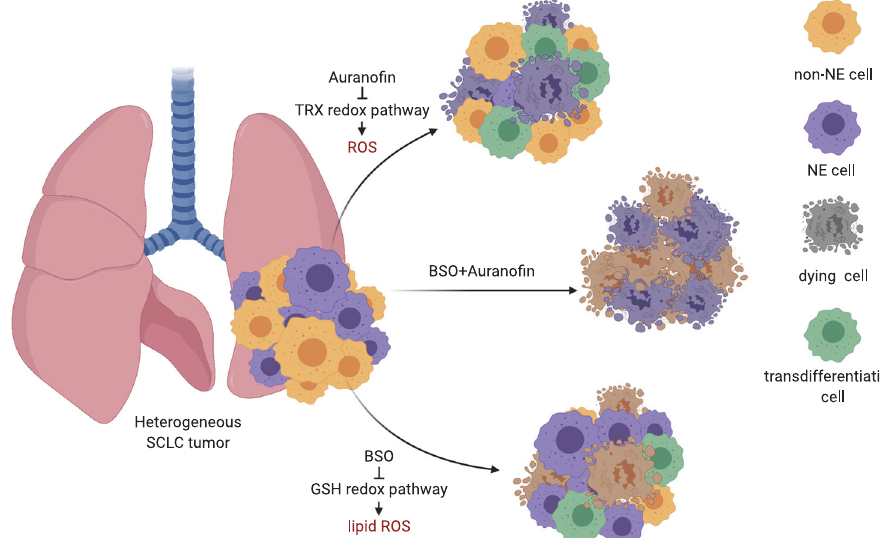
Fig. 7 SCLC non-NE/NE subtypes segregate by lipid ROS/ROS vulnerability. Heterogeneous SCLC tumors contain NE cells expressing high levels of ASCL1 and low levels of REST1 and non-NE cells with an inverse expression pattern. Upon induction of ferroptosis by BSO, non-NE cells die due to excessive lipid ROS accumulation. NE cells, in turn, undergo ROS-dependent cell death upon TRX pathway inhibition. Surviving cellular fractions in both single treatment arms can transdifferentiate under treatment, thereby escaping therapy. Dual targeting prevents selection and plasticity in SCLC. NE neuroendocrine, ROS reactive oxygen species, GSH glutathione, TRX thioredoxin. The scheme was drawn using fully licensed